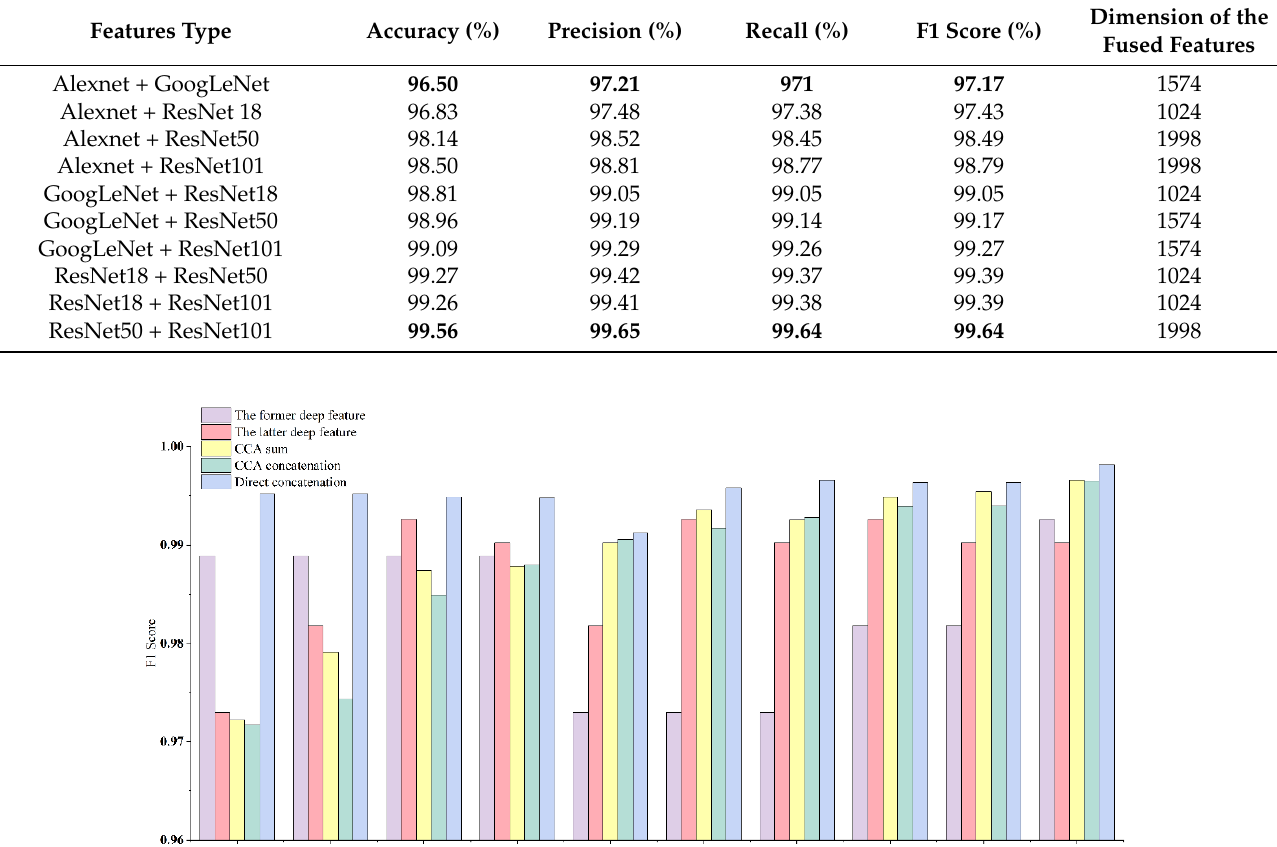
Table 8. The best performance comparison between single deep feature and different fusion method (bold font shows the best performance).